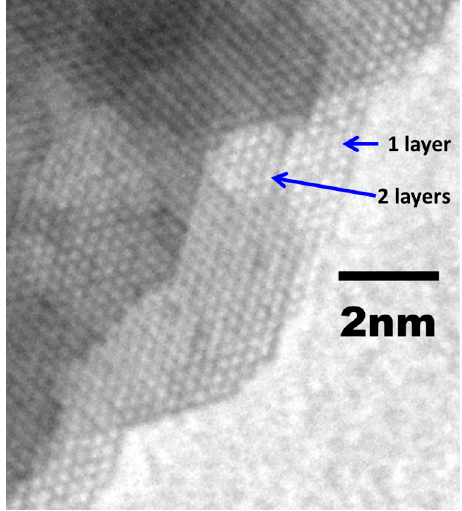
Figure 4. Observation of planar two-dimensional ZnO synthesized using the hydrothermal growth technique. HR-TEM shows mono-layer and multi-layers of ZnO with atoms arranged in a honeycomb lattice. Figure kindly provided by T.